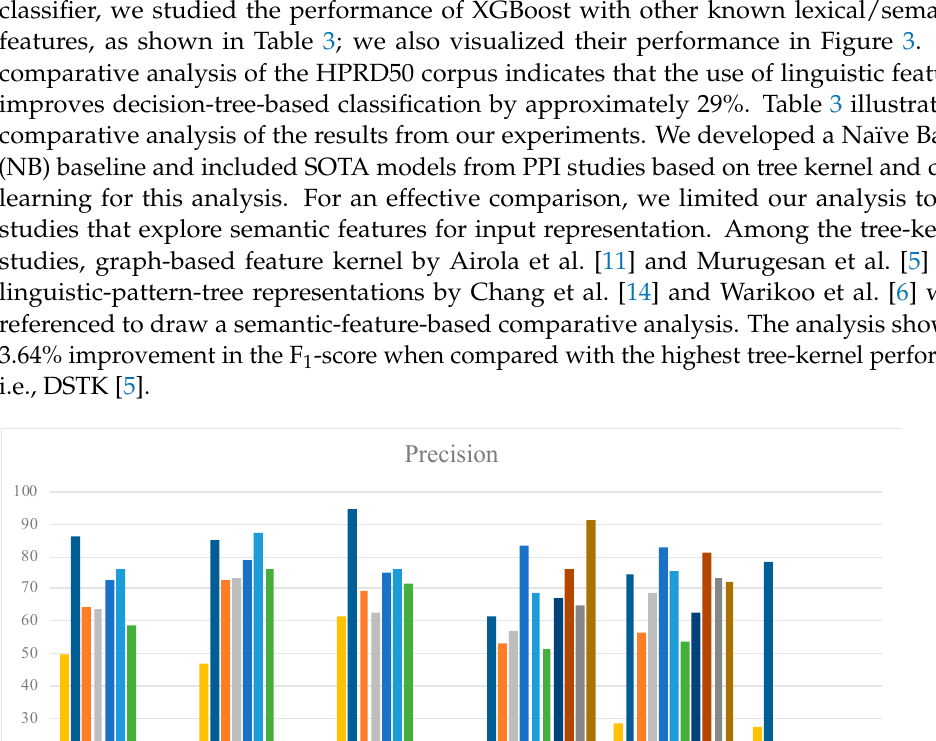
Table 3. XGBoost ‐ based comparative feature analysis on HPRD50 corpus.